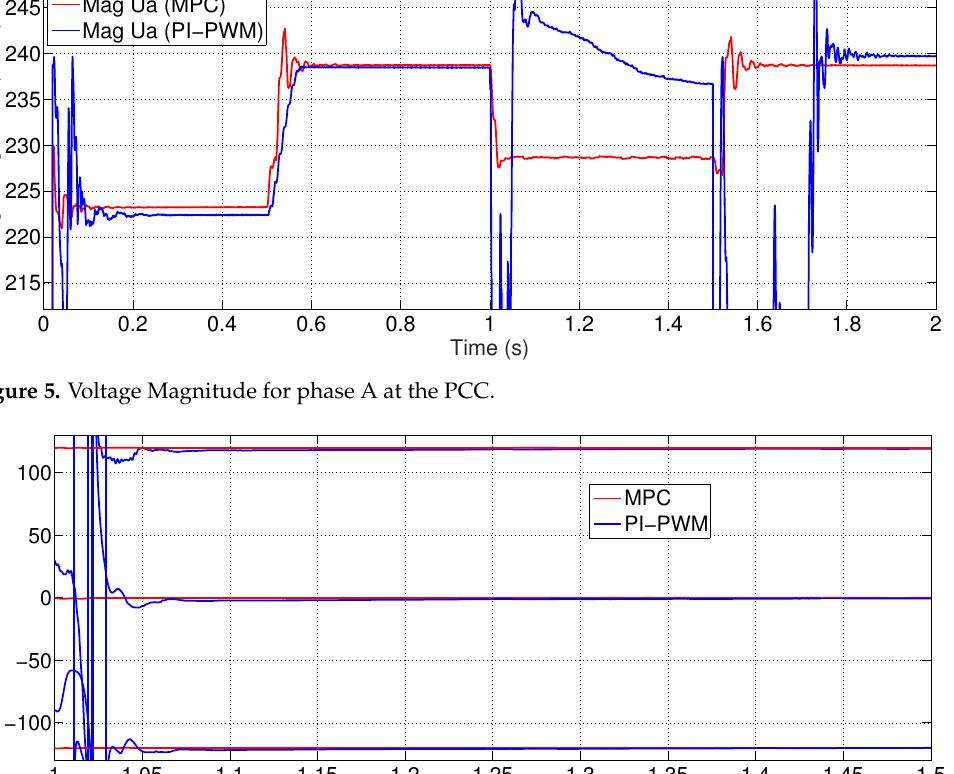
Figure 6. Absolute voltage phase angle value of the voltages at the Point of Common Coupling (PCC) during the blackout of the main